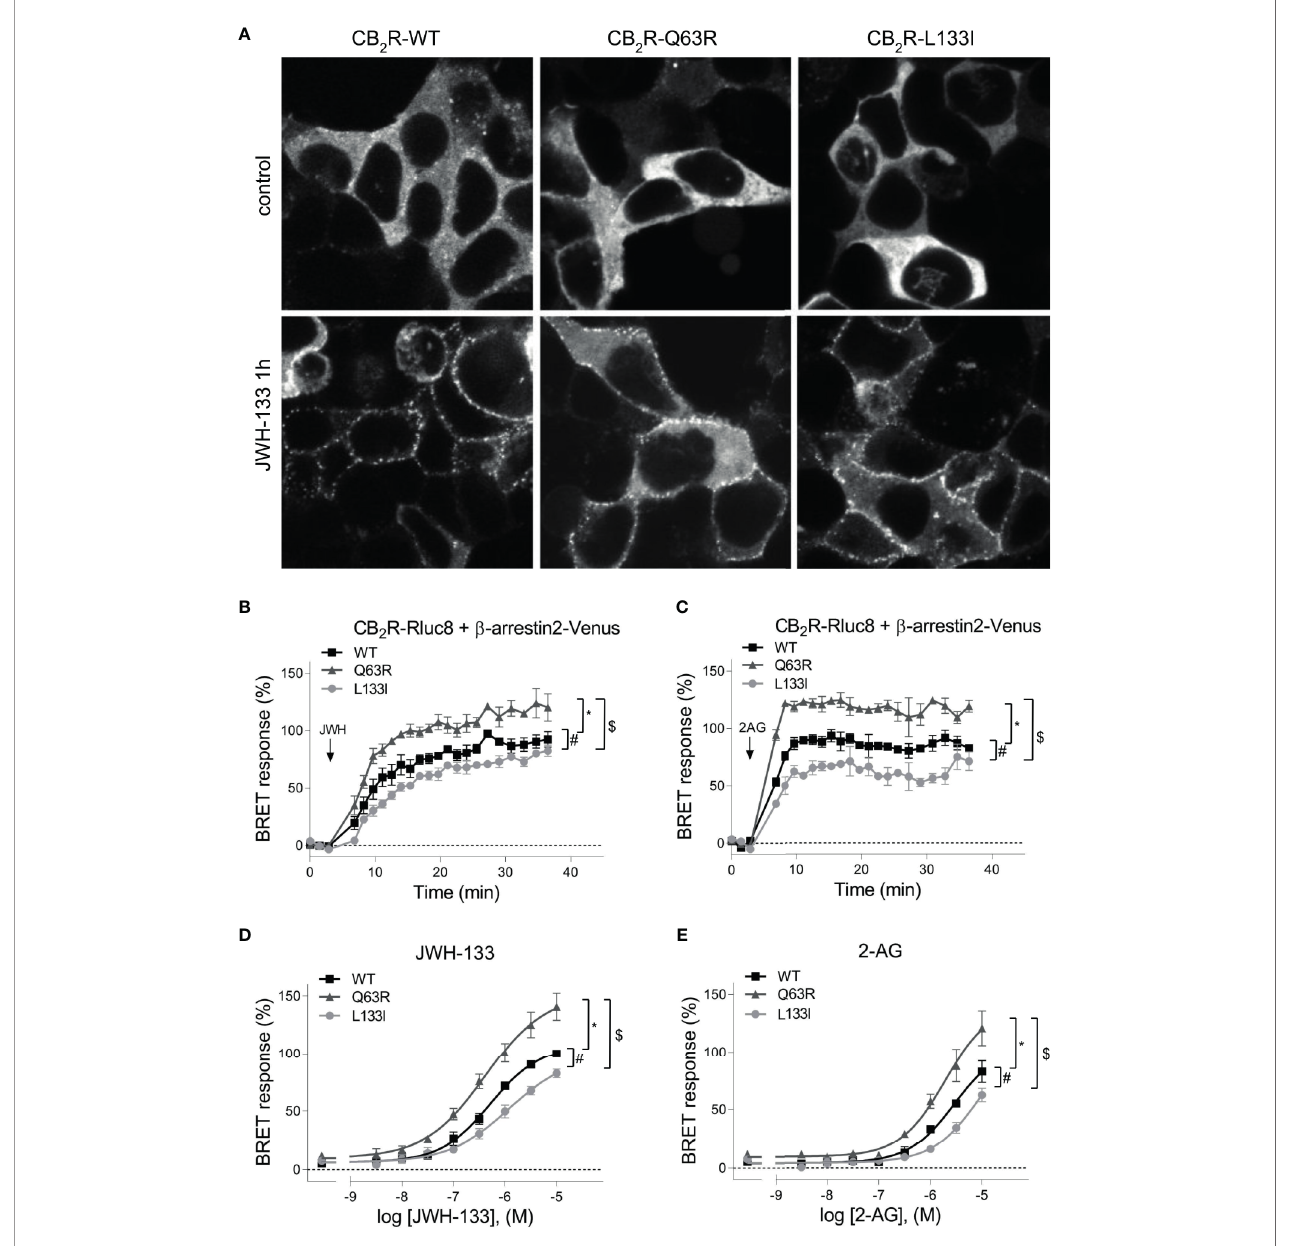
FIGURE 2 | (A) b -arrestin2 localization: HEK 293T cells were co-transfected with unlabeled CB 2 Rs and b -arrestin2 – Venus. Cells were untreated (control) or stimulated with JWH-133 (10 m M), for 1 hour. The cells were visualized by laser scanning confocal microscopy. (B – E) b -arrestin2 coupling to CB 2 Rs: BRET measurements showing the recruitment of b -arrestin2 to CB 2 receptors upon agonist stimulus. CB 2 R-Rluc8 constructs (CB 2 R-WT: black squares, CB 2 R-Q63R: grey triangles, or CB 2 R-L133I: grey circles) were co-expressed with b -arr – Venus in HEK 293T cells, and BRET was measured upon JWH-133 (10 m M, B ) or 2-AG (10 m M, C ) stimulus. Data are shown as the percentage of the maximal response to 10 -5 M JWH-133. Measurements were baseline-corrected to vehicle data (indicated by horizontal dashed line). Arrows indicate the time point of stimulation. (C) Concentration-response curves showing the recruitment of b -arrestin2 to CB 2 receptors: in HEK 293T cells under basal and different JWH-133 (logEC50: -6.276; -6.373; -5.922 for wild-type, Q63R and L133I CB2 receptors) (D) or 2-AG-stimulated conditions (logEC50: -5.538; -5.725; -5.040 for wild-type, Q63R and L133I CB2 receptors) (E) . The results were analyzed by two-way ANOVA (stimulation and mutation) and Tukey ’ s post-hoc test was applied for pairwise comparisons of the wild-type and mutant CB 2 R. The mean ± S.E.M. of the data in the form of 4 experiments is in the results. *, #, $ indicate a signi fi cant difference between control vs. CB 2 R-Q63R, control vs. CB 2 R-L133I, and CB 2 R-L133I vs . CB 2 R-Q63R, respectively